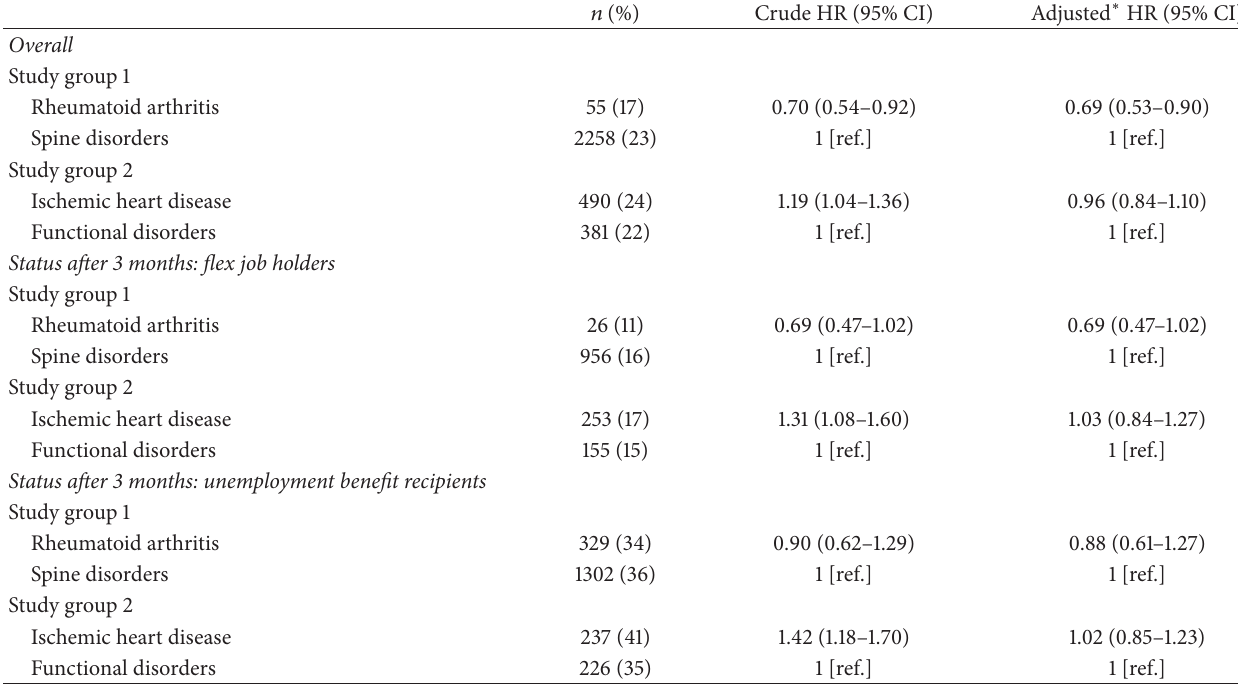
Table 2: Risk of disability pension for different diagnoses stratified by employment status at baseline.